Question: Name the type of graph shown.
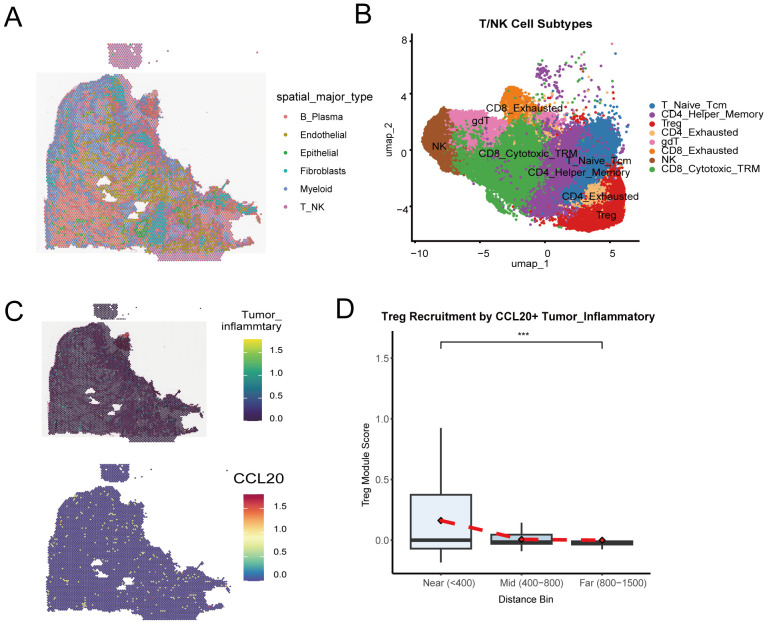
Answer: heatmap